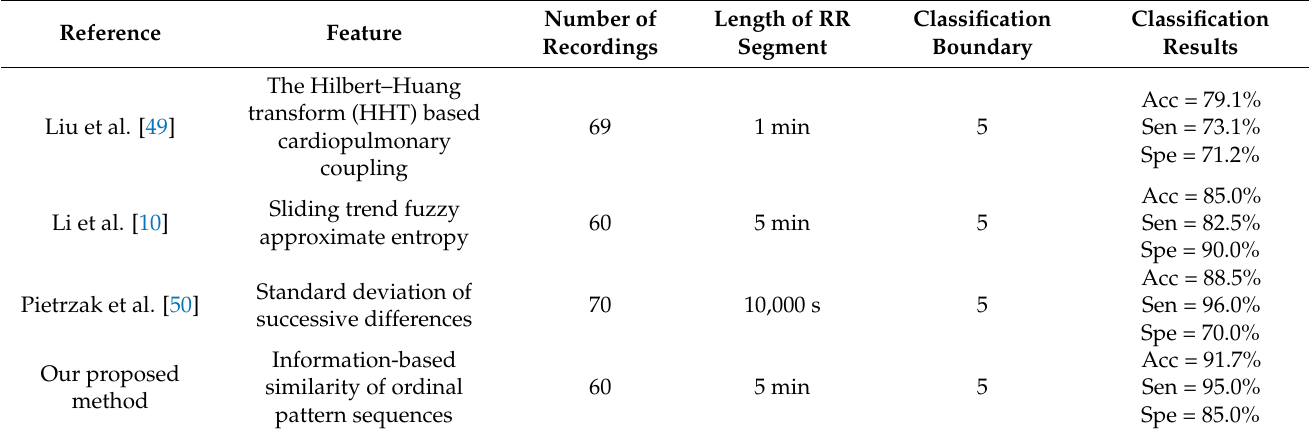
Table 6, OP_IBS performed well. It achieved the highest accuracy of 91.7%. The sensitivity (95%) and specificity (85%) were also relatively high with a good balance. These results prove the robustness and applicability of the IBS method. Table 6. Comparison of classification results between the proposed method and previous studies in Physionet